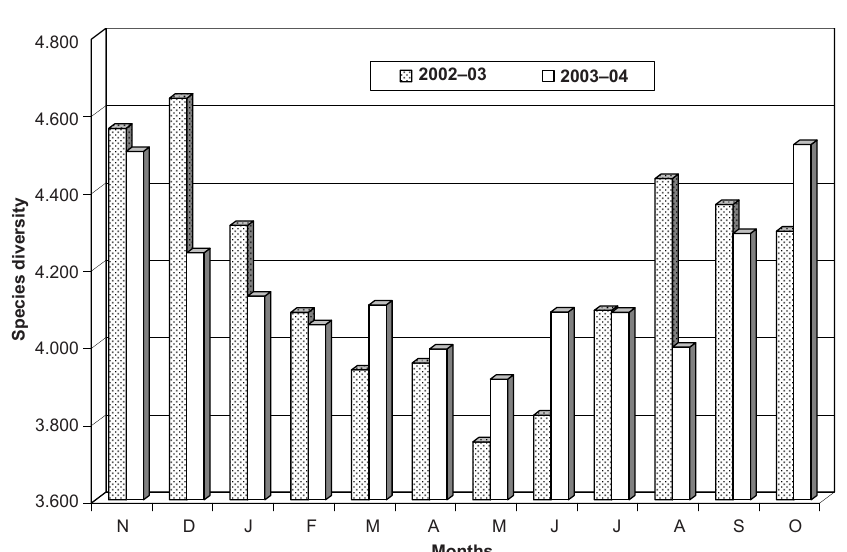
Figure 8. Monthly variations in species diversity of zooplankton